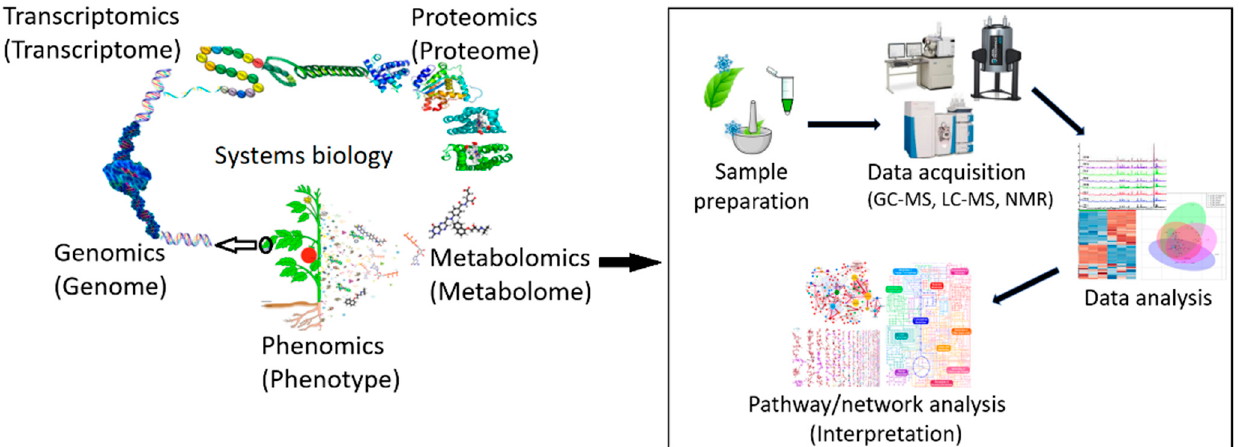
Figure 4. The core omic advances in systems biology. As an interdisciplinary field, systems biology provides a holistic view of a biological system via correlation between biomolecules at different organizational levels (genome, transcriptome, proteome, and metabolome) with the emergence of the biological phenomena (phenotype).